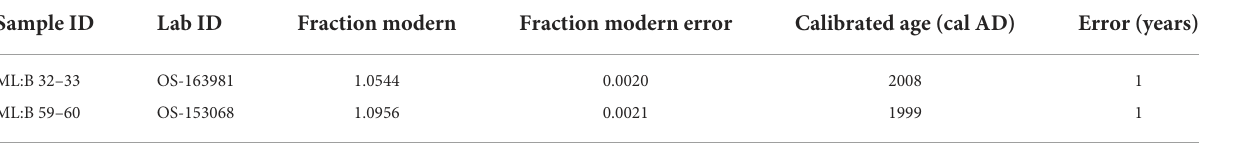
TABLE 1 Radiocarbon results for the Mary Lawson cores.